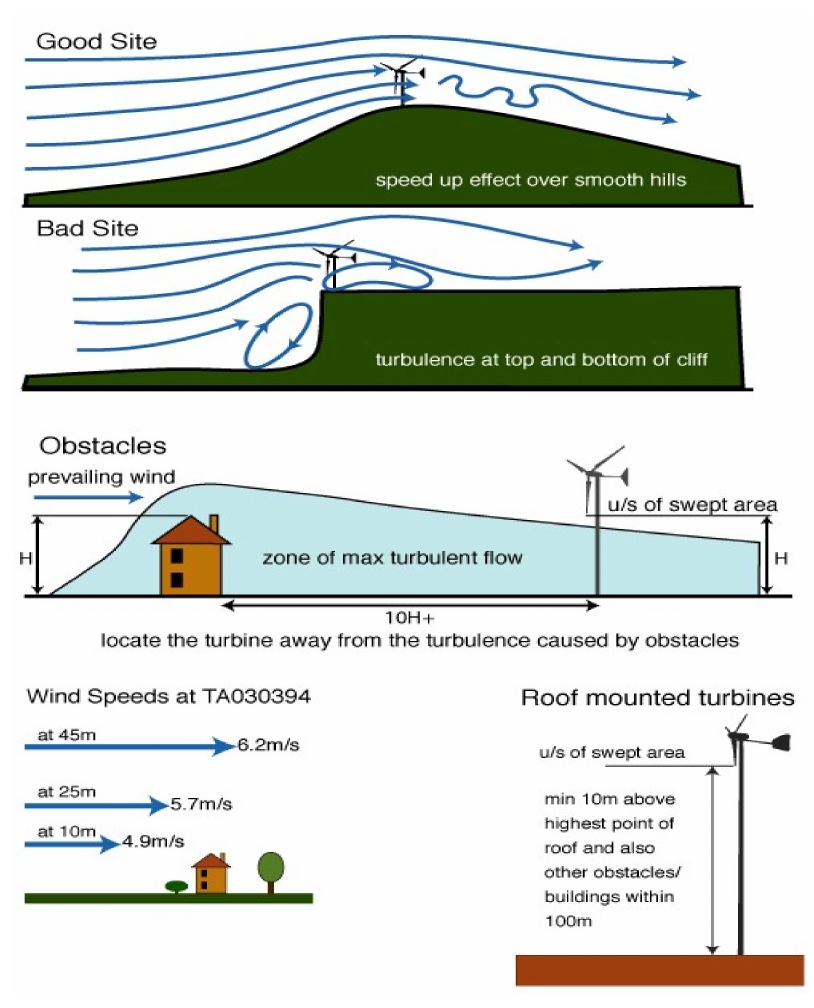
Figure 4. Comparing various site locations for the installation of a wind farm